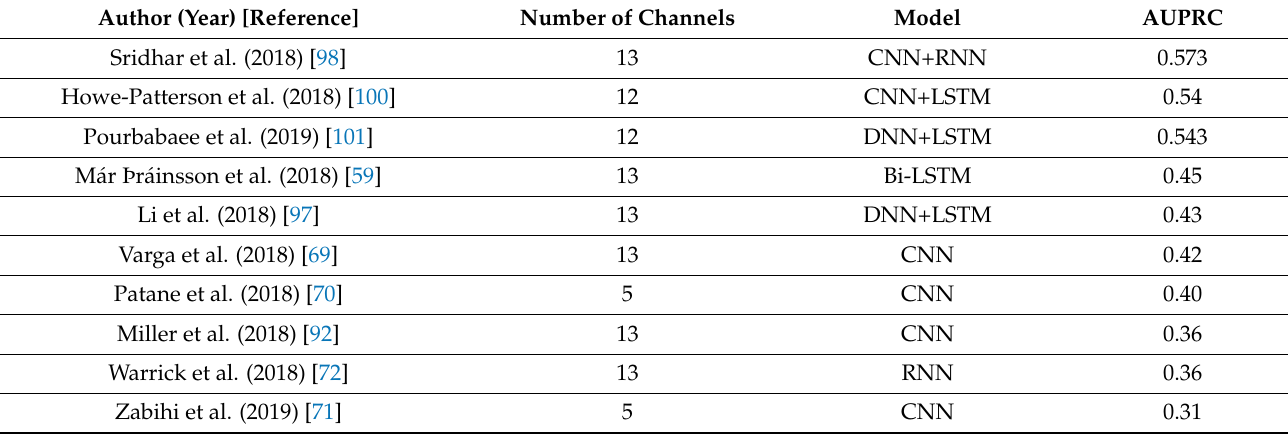
Table 8. Comparison of detection of non-apnea/hypopnea sleep arousal in PhysioNet 2018 Computational